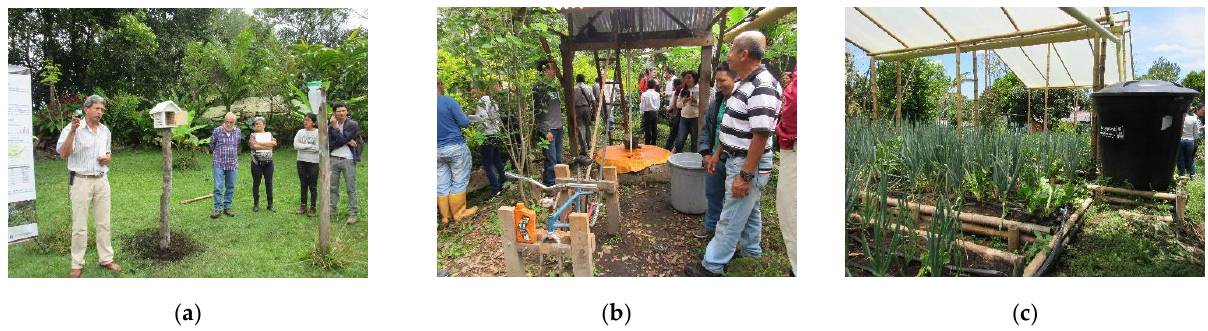
Figure 4. Various practices identified: meteorological station ( a ), ram pump to obtain water ( b ), and irrigation systems ( c ). Source: authors.